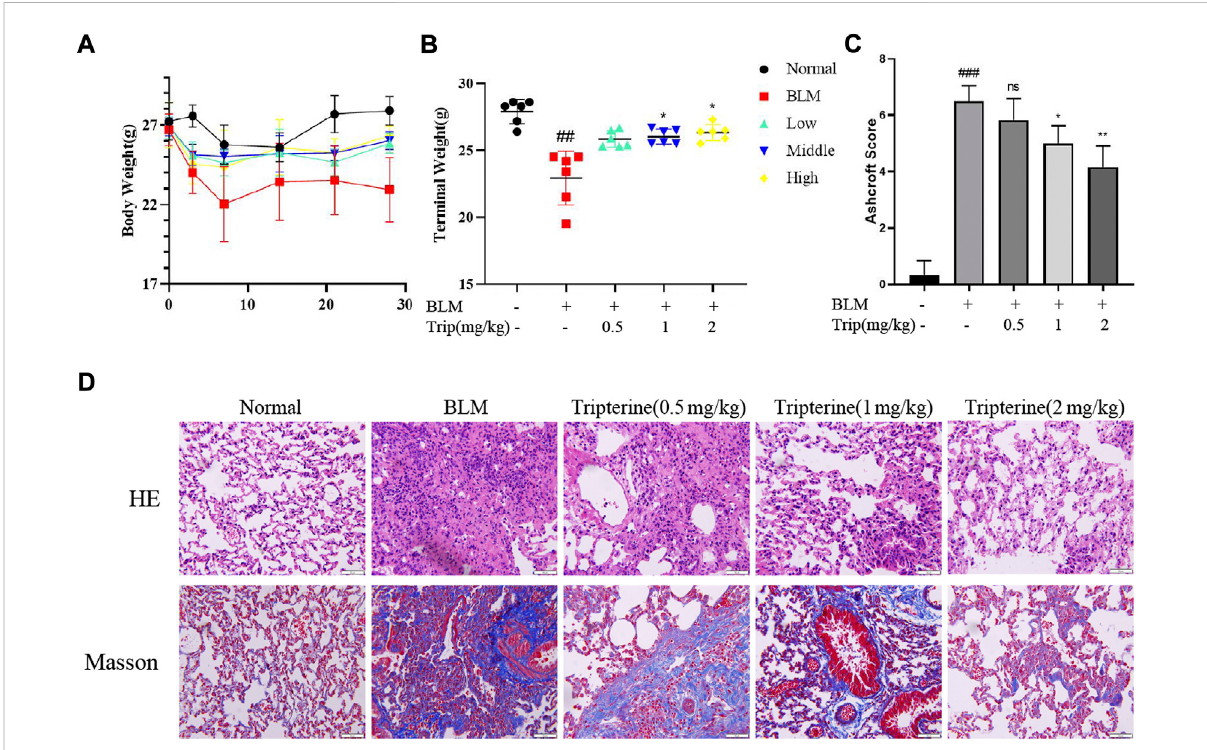
FIGURE 5 Changes in the body weight and lung pathology after tripterine treatment. (A) Changes in the body weight of the mice at different time points. (B) The endpoint weight of the mice in each group. (C) Ashcroft scores in a different group. (D) Haematoxylin-Eosin and Masson staining results of lung sections in a different group. Scale bars: 50 μ m. Data are reported in the fi gures as the mean ± standard deviation, n = 6 in each group. ### p < 0.001 vs the normal group; * p < 0.05, ** p < 0.01, and *** p < 0.001 vs. the BLM-treated group. BLM, bleomycin (5 mg/kg); Trip,